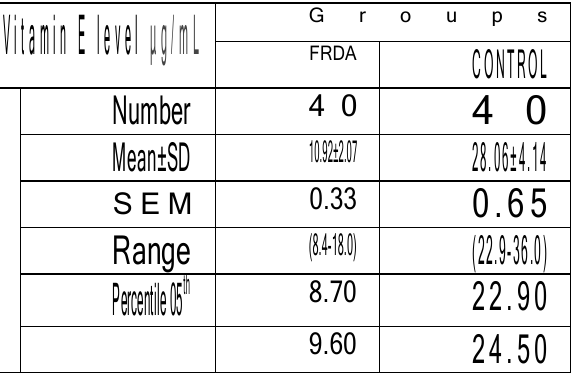
Table (3-2)The mean and standard deviation of level